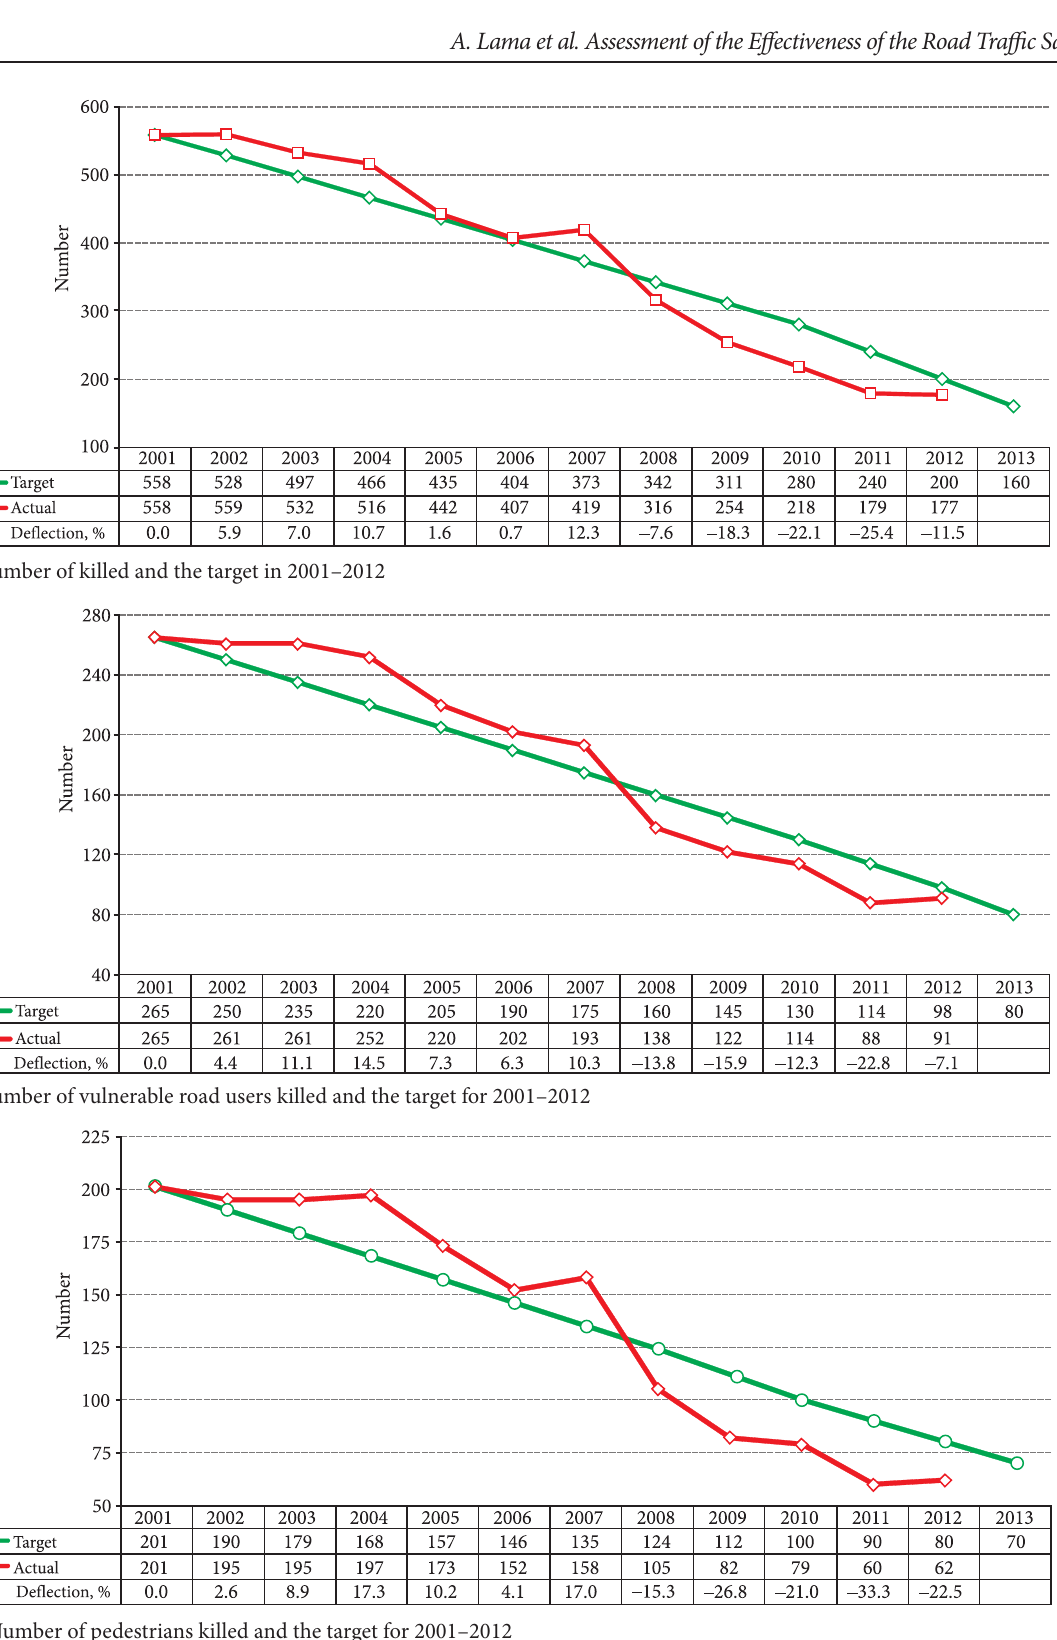
Fig. 10. Number of pedestrians killed and the target for